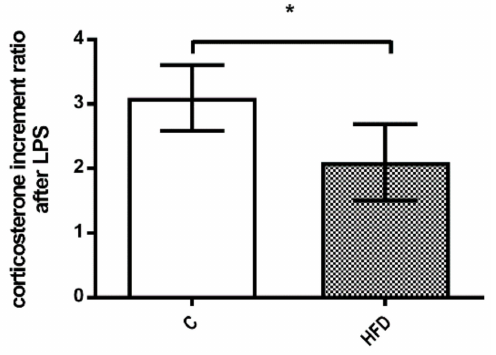
Figure 5. The corticosterone response to LPS injection. The HFD group had significantly lower corticosterone increment ratio after LPS injection. The results suggest inadequate corticosterone response to septic shock in NAFLD. (* p <